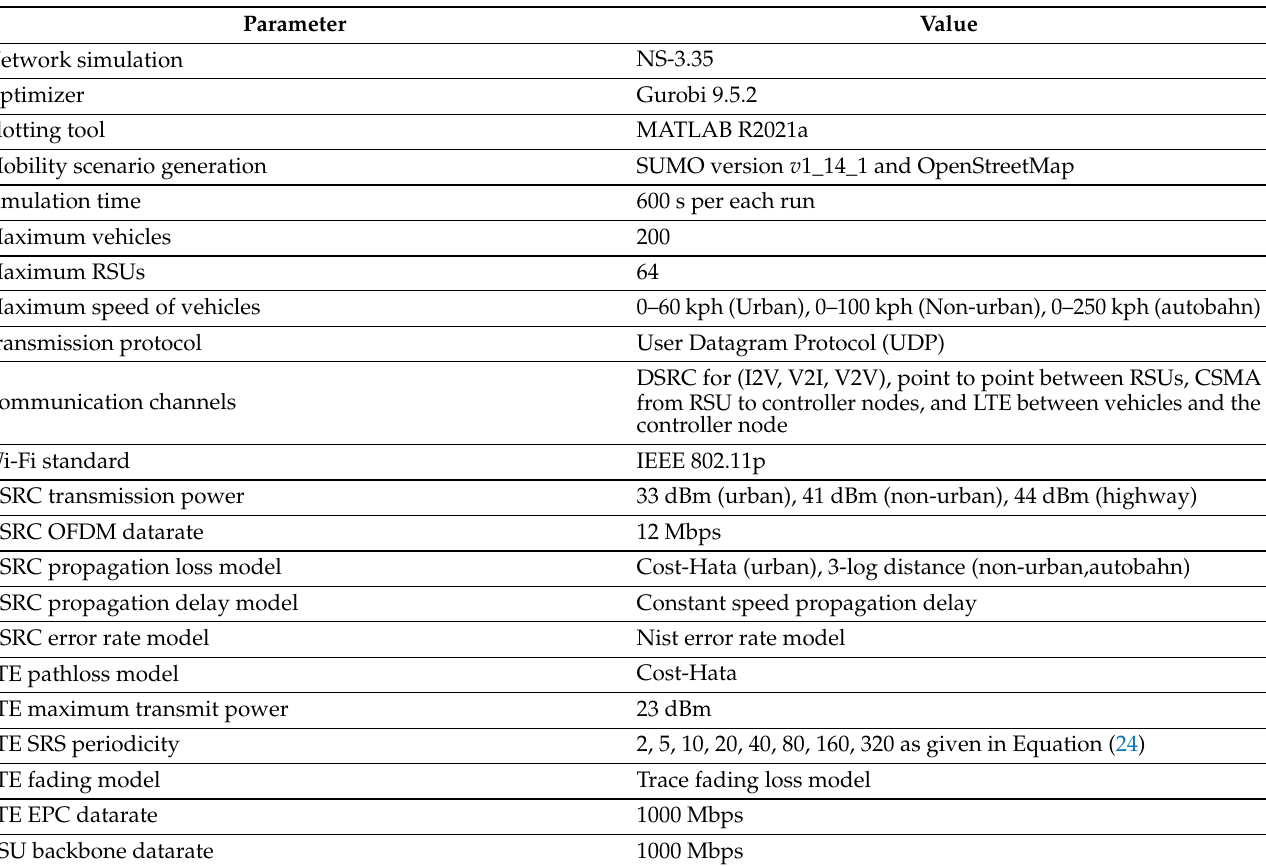
Table 2. Summary table of simulation